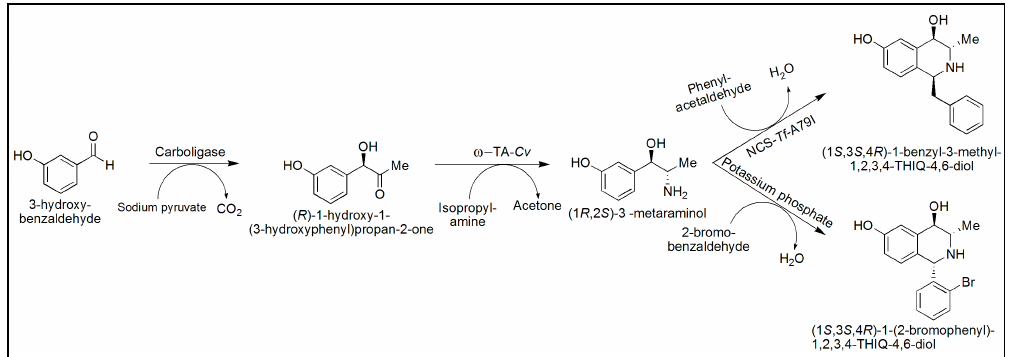
Figure 9. Enzymatic and Chemo-enzymatic synthesis of 1-benzyl-THIQs employing the cascade of carboligase, ω -TA and NCS [118]. (Reaction conditions: step 1: 10 mM substrate, HEPES buffer (100 mM, pH 7.5), 5 mM MgCl 2 , 0.1 mM ThDP, 0.05 mM FAD, 20 mM sodium pyruvate, 2.5% DMSO ( v / v ),